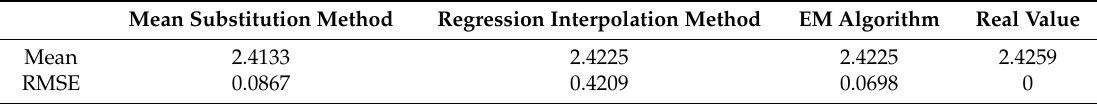
Table 2. Comparison of three data interpolation methods for a 20% missing rate. Table 1. Comparison of three data interpolation methods for a 10% missing rate.